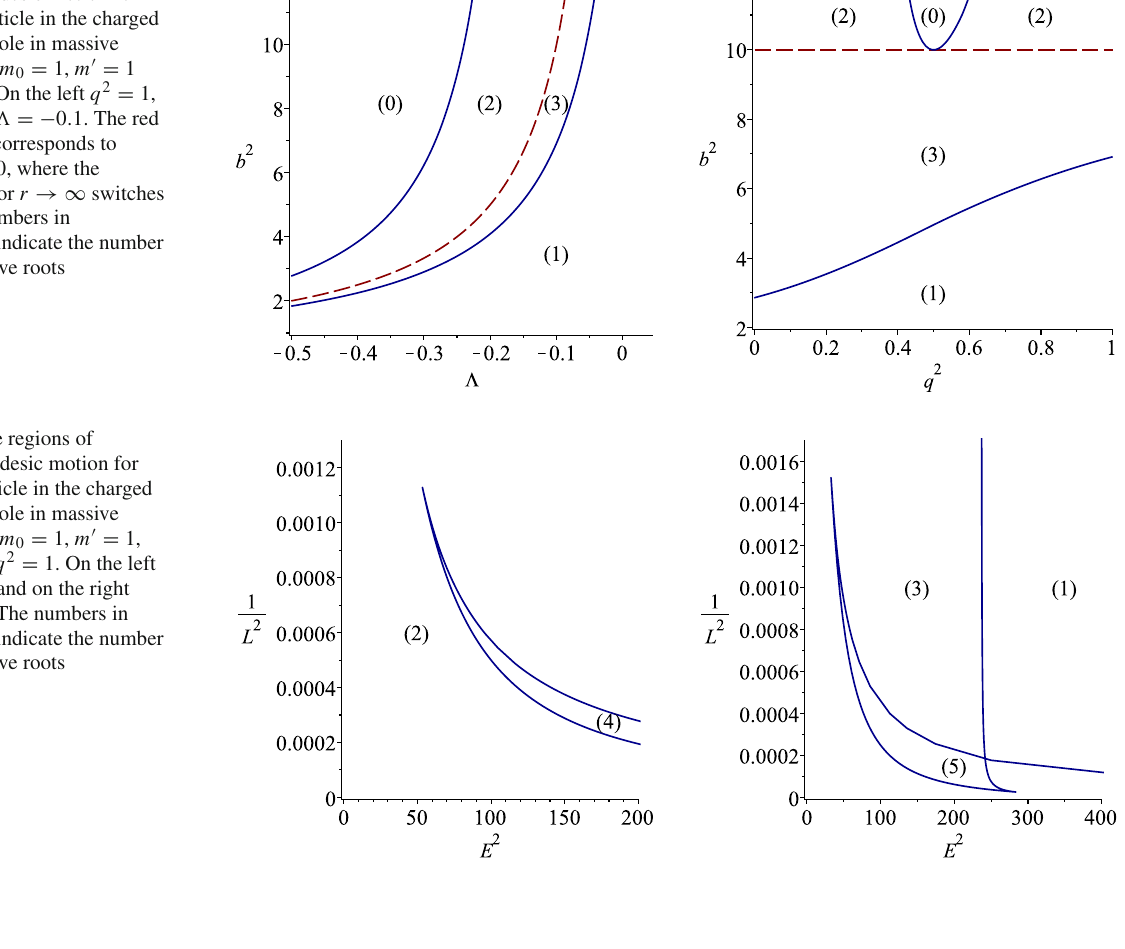
(b) Bound orbit (3) with E 2 = 36 and L − 2 = 0 . 01